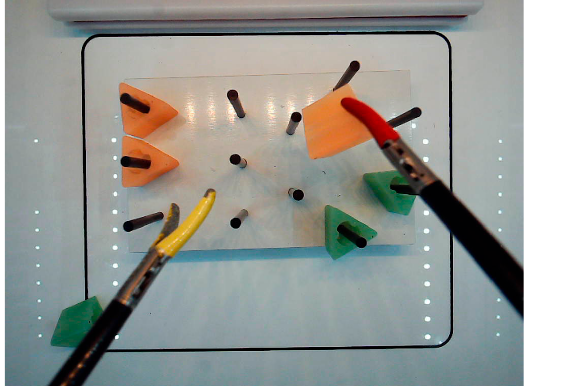
Figure 1. Pegboard with 12 pegs, and six ring-like objects (triangles) in the IBTS.